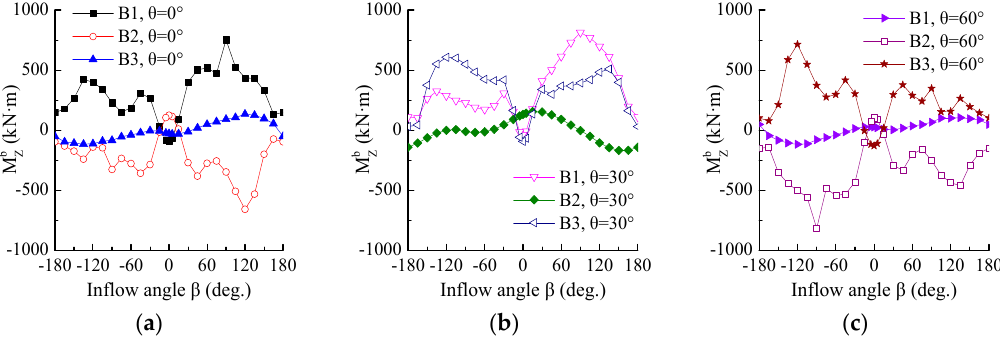
Figure 16. Moments M b of the three blades in the wind rotor for different parking positions: ( a ) θ = 0 ˝ parking position; ( b ) θ = 30 ˝ parking position; ( c ) θ = 60 ˝ parking